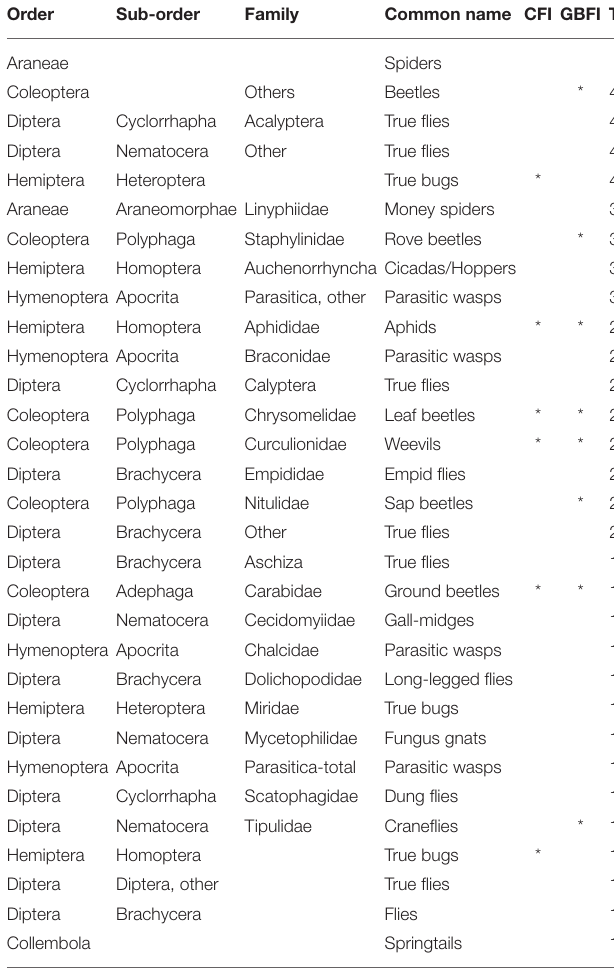
TABLE 6 | Most commonly occurring invertebrate taxa across the seven